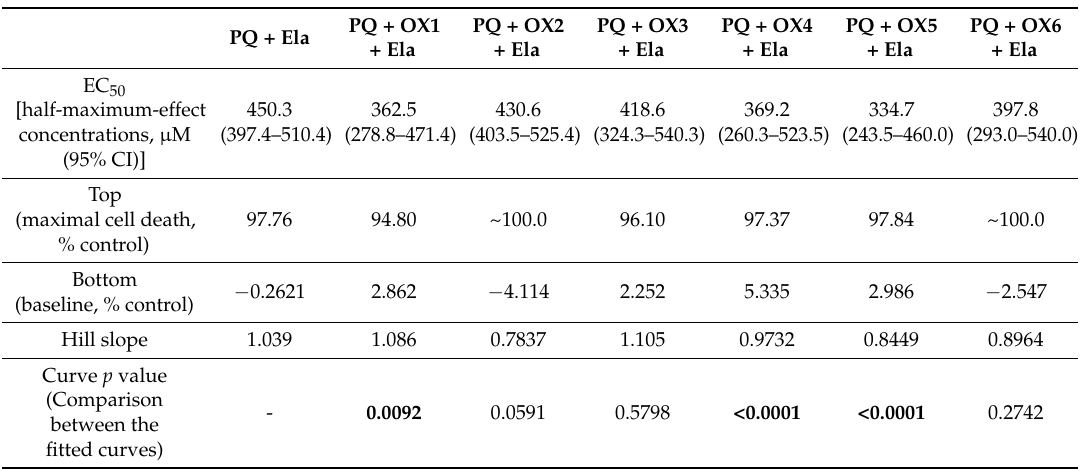
Table 2. EC 50 (half-maximum-effect concentrations), TOP (maximal effect), BOTTOM (baseline), and Hill Slope values of the paraquat (PQ) concentration—response curves, in the presence of the P-gp inhibitor, Elacridar (Ela, 10.0 µ M), with (PQ + OXs + Ela) or without (PQ + Ela) simultaneous exposure to the six tested oxygenated xanthones, OX 1–6 (20.0 µ